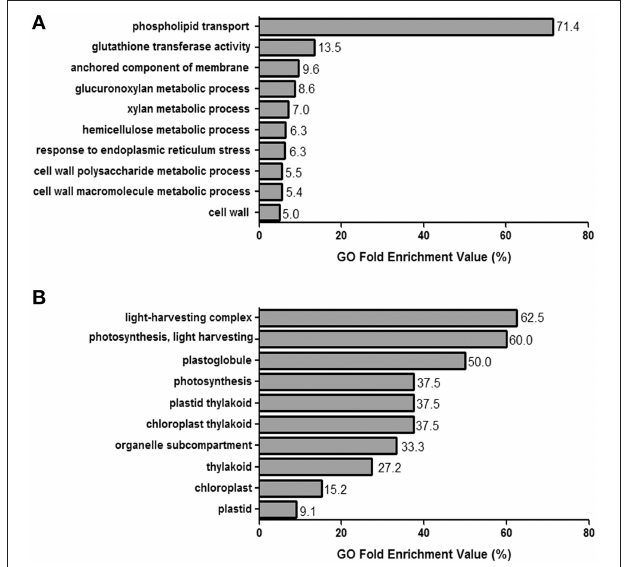
FIGURE 2 | GO enrichment analysis.(A,B) The 10 GO terms that are most representative for each set of the 713 up-regulated and 364 down-regulated genes, as defined by those for which log 2 FC ≥ 2 and log 2 FC ≥ − 2 , respectively. GO enrichment values (represented as percentages) were calculated by generating the ratios for the number of observed over expected GO term repeats.